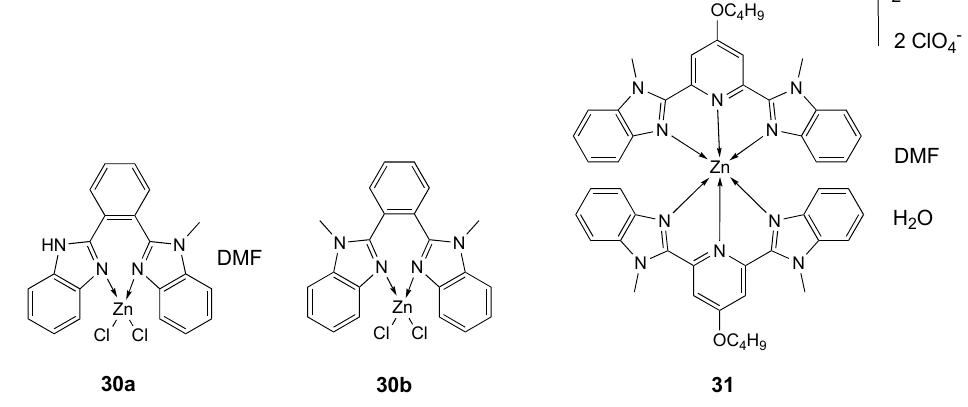
Figure 17. Structure of the zinc complexes 30a , 30b and 31 . Table 9. IC 50 values ( µ M) for zinc complexes 29 – 31 and reference compound cisplatin against di ff erent tumor and normal (LO2) cell lines, after an incubation time 72